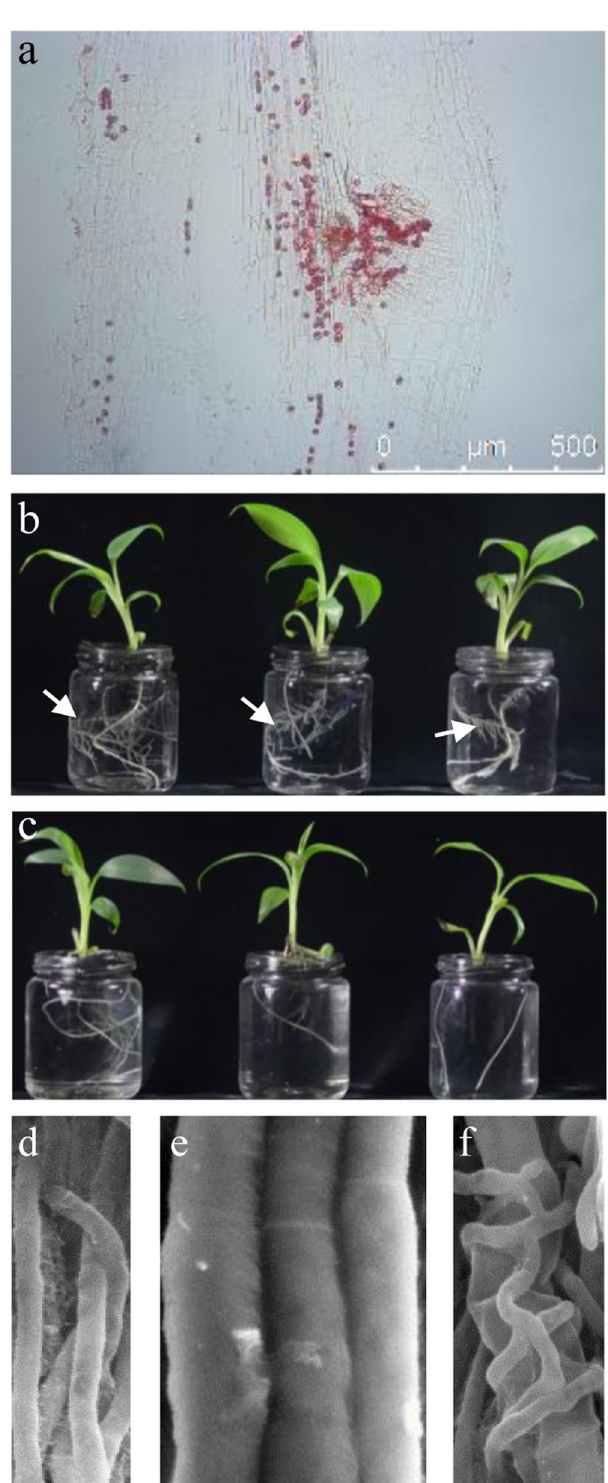
Fig. 3 P. indica stimulates lateral root formation in banana plants and restricts Foc TR4 growth in vitro. a P. indica chlamydospores colonize banana roots and aggregate at the lateral root primordium site. b Banana plantlets treated by P. indica inoculum (1 × 10 5 chlamydospores/ml) and grown in ½ Hoagland medium exhibit more lateral roots. Arrows indicate lateral roots. c Untreated banana plantlets grown in ½ Hoagland medium as controls. d , e Hypha size of P. indica ( d ) and Foc TR4 ( e ) under scanning electron microscope. f P. indica hyphae clasp and collapse the hyphae of Foc TR4. Scale bars, 2 μ